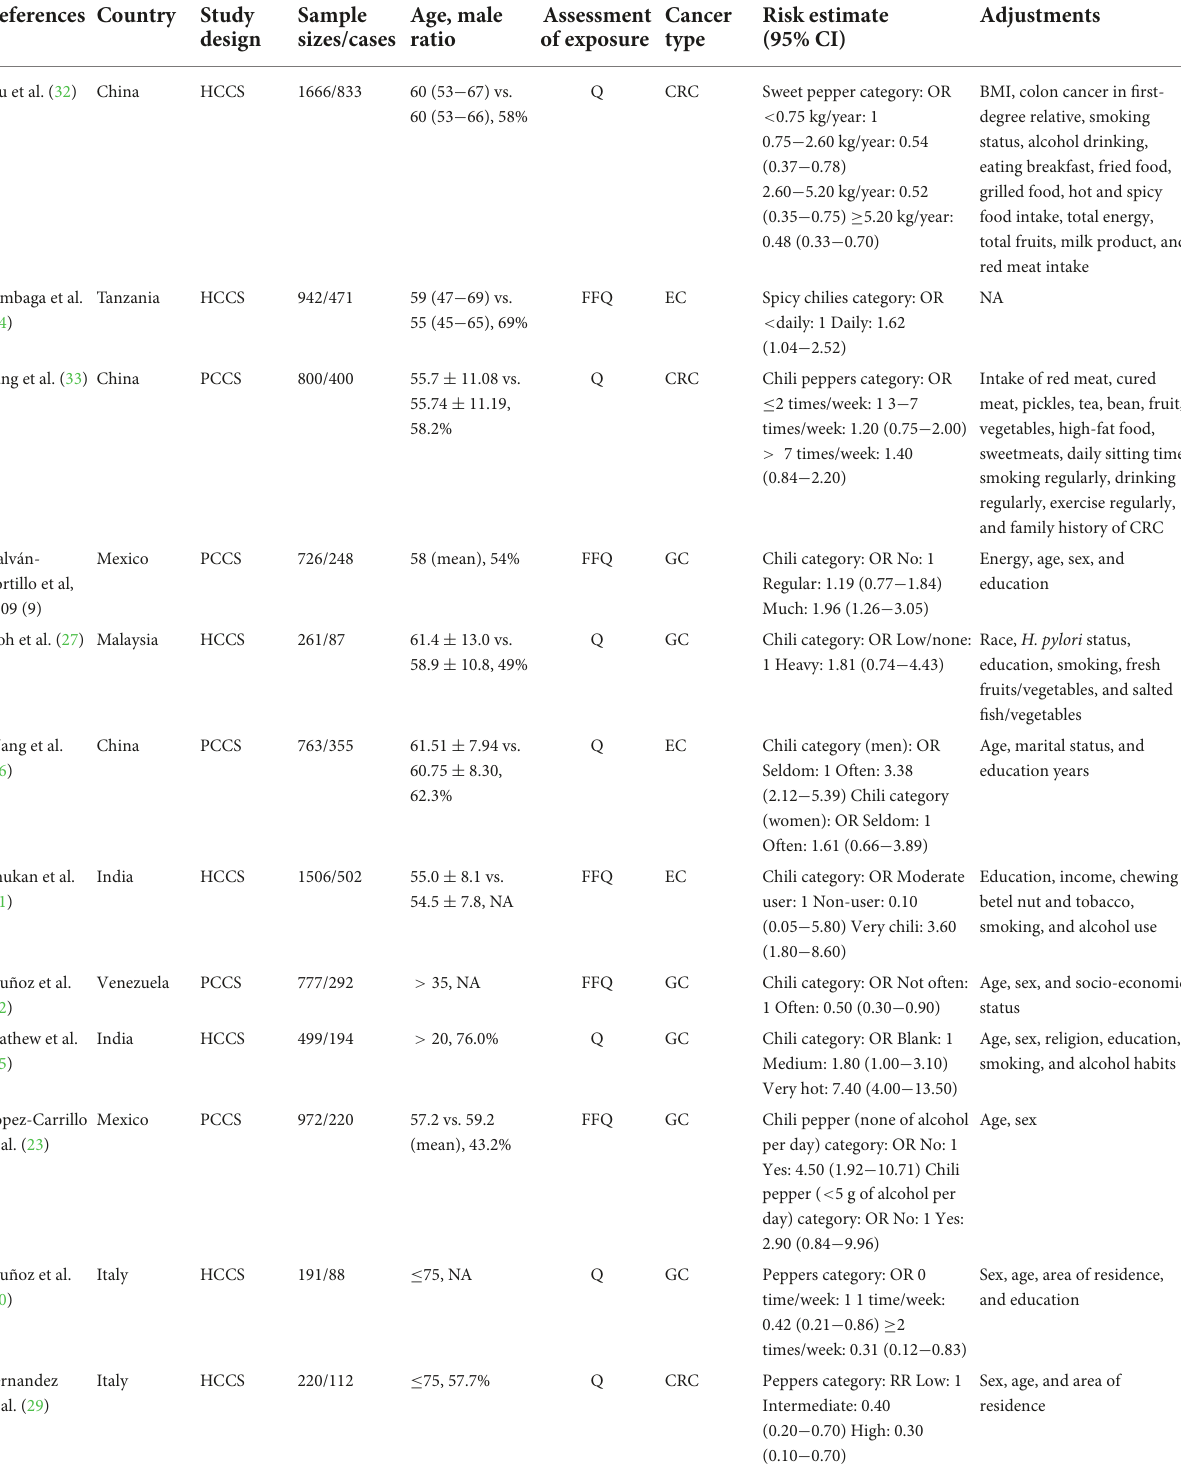
TABLE 1 Characteristics of studies included in the